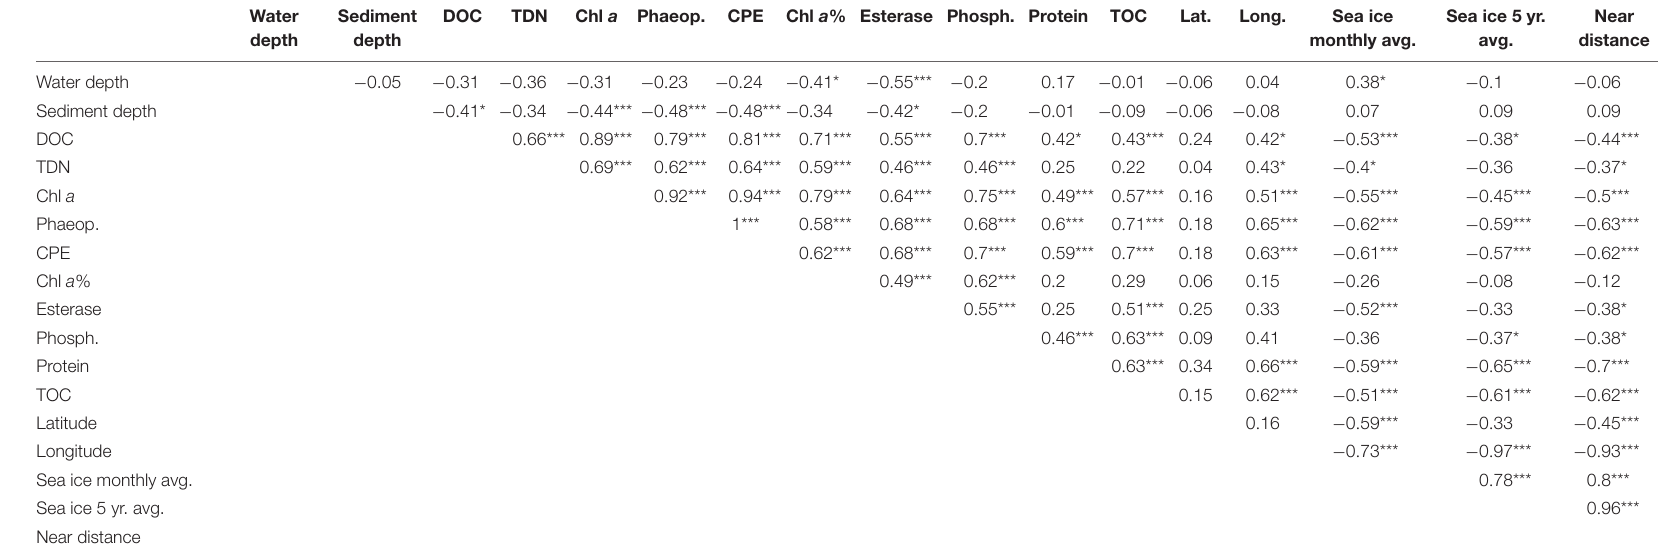
TABLE 1 | Pearson correlation matrix between DOC and TDN concentrations, and phytodetrital proxies and benthic community data from the LTER HAUSGARTEN program for the top 5 cm of